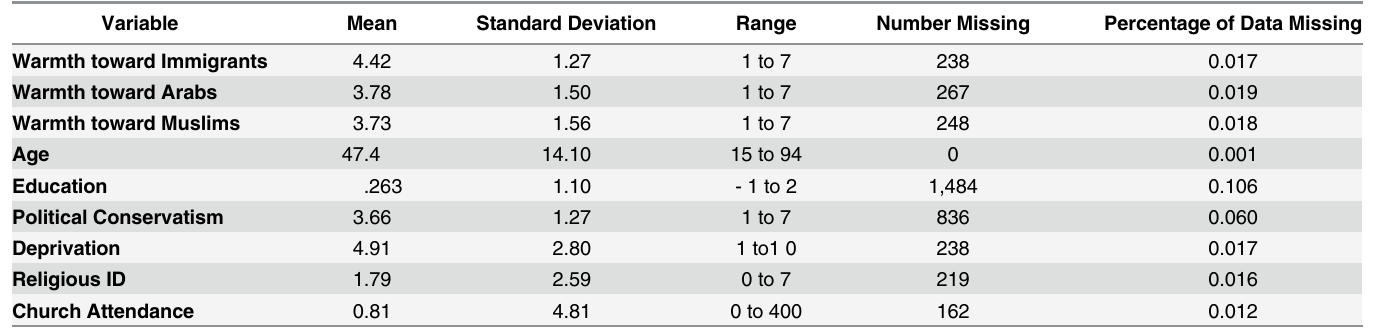
Table 1. Interval/Ordinal Variables Used in